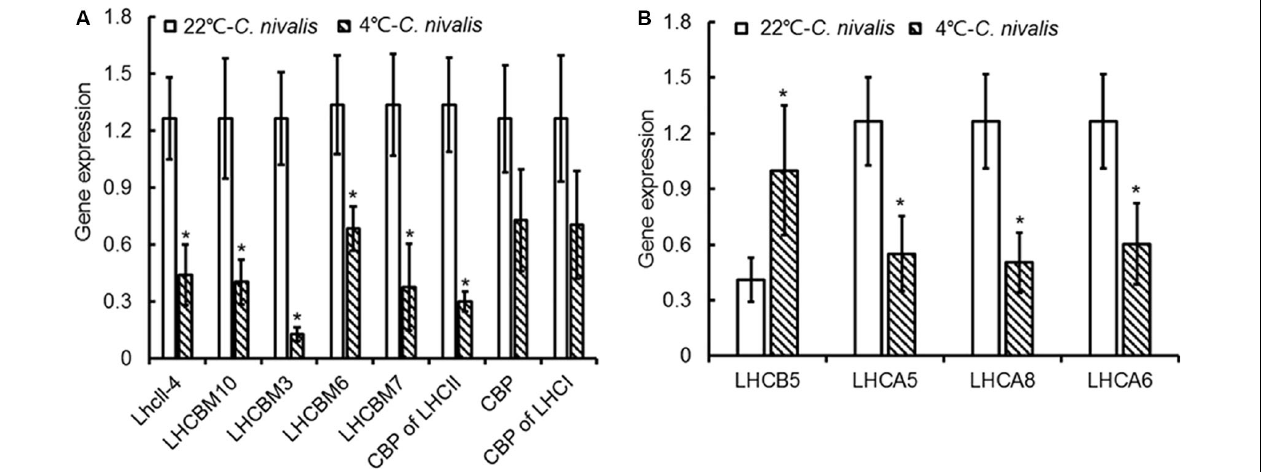
FIGURE 9 | Expression of genes related to light-harvesting in C. nivalis at 22 ◦ C and 4 ◦ C. (A) Chlorophyll-binding protein in light-harvesting complex. (B) Chlorophyll-binding protein in photosystem. LhcII-4, light-harvesting chlorophyll-a/b binding protein; LHCBM10, light-harvesting complex II protein m10; LHCBM3, light-harvesting complex II chlorophyll-a/b binding protein M3; LHCBM6, chlorophyll-a/b binding protein of LHCII type I, chloroplast precursor; CPB of LHCII, chlorophyll-a/b binding protein of LHCII; CPB, chlorophyll-a/b binding protein; CPB of LHCI, chlorophyll-a/b binding protein of LHCI; LHCB5, light-harvesting chlorophyll-a/b binding protein of PSII; LHCA5, light-harvesting chlorophyll-a/b binding protein of PSI; LHCA8, light-harvesting chlorophyll-a/b binding protein of PSI; LHCA6, light-harvesting chlorophyll-a/b binding protein of PSI. The significance of the differences between 22 and 4 ◦ C in the C. nivalis were tested using a one-way ANOVA. * p < 0.05, ** p <